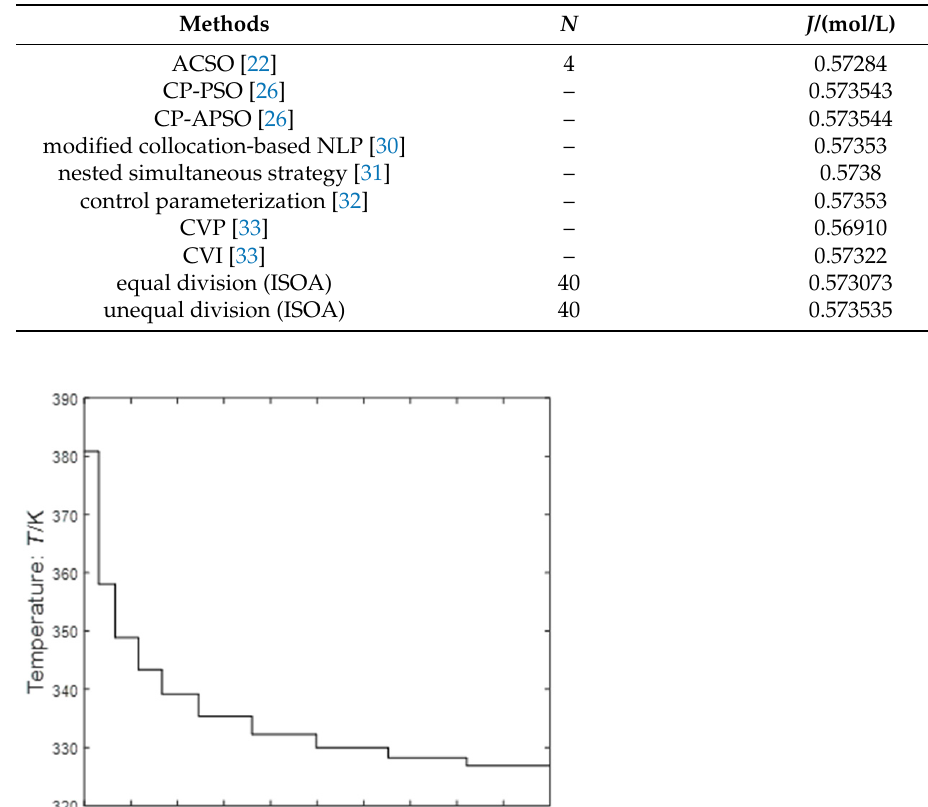
Figure 4. Optimal temperature control trajectory ( N = 30). Figure 5. Optimal trajectory of state variables. 5.4. Case 2: Parallel Reaction Problem of Tubular Reactor Parallel reaction means that reactants can carry out two or more different reactions in parallel to obtain different products. For example, ethanol can undergo two reactions of dehydration and dehydrogenation in parallel. In our paper, we introduce a dynamic optimization problem with saturation characteristics of control variables, which is cited by many scholars. The process of this problem is A → B and A → C . By determining